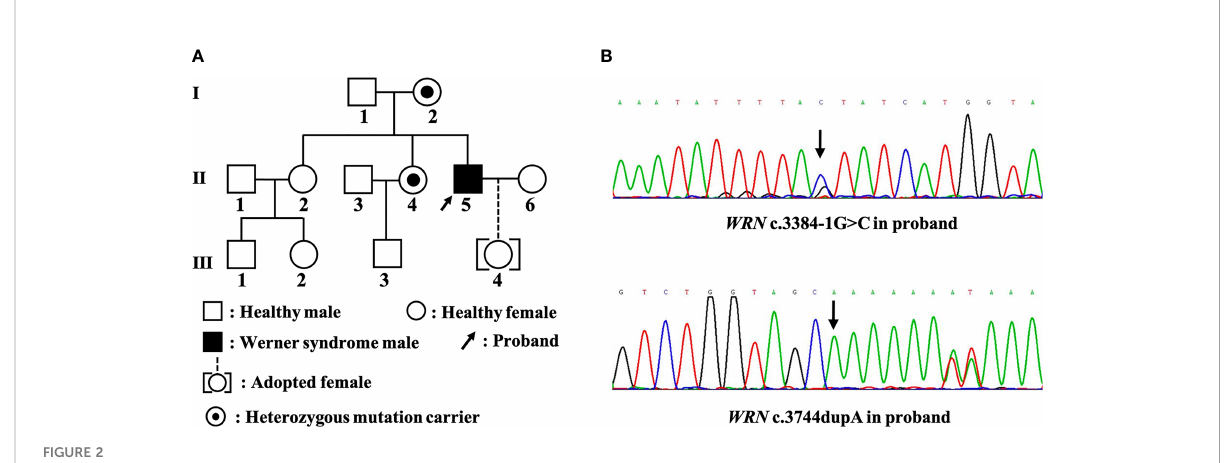
FIGURE 2 (A) Family map and (B) Sanger sequencing